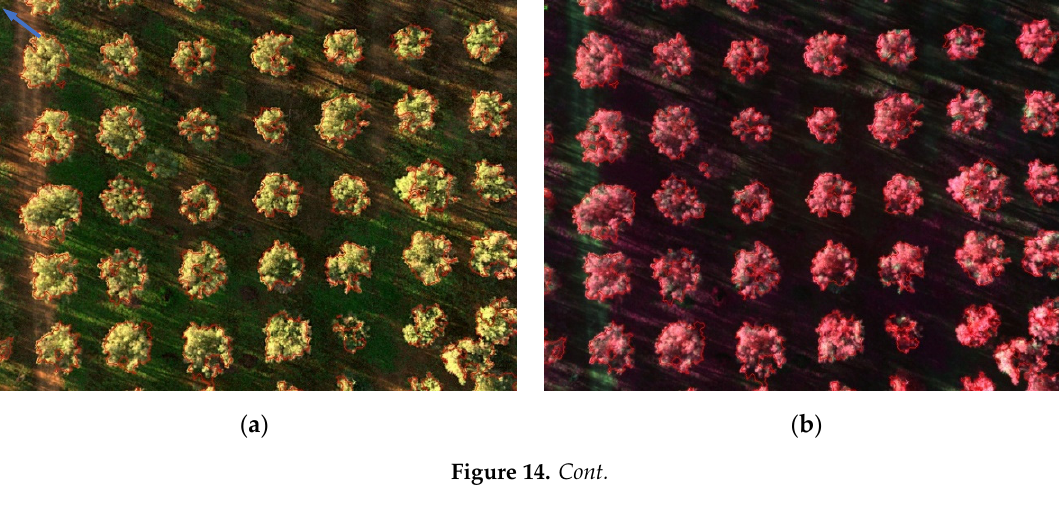
( d ) Figure 14. (a ) Segmented RGB image; ( b ) segmented CIR image; ( c ) NDVI image; ( d ) probability map. The blue arrow in the upper left corner of (a) indicates a classification error. 4. Discussion The results shown in the previous section indicate that high classifier sensitivity and precision were achieved in both training and test sets. It is worth noting that the test images were acquired in suboptimal conditions, with evident shadows cast on the ground and self-shadowing; however, both the segmentation and classification algorithms succeeded. This is very important, because due to logistic constraints, it is not always possible to survey a field under optimal irradiation, i.e., when the sun is directly overhead. Parameters such as gain and exposure time were optimized automatically by the multispectral camera according to shooting conditions and were saved in image metadata. According to manufacturer’s data, automatic gain control keeps the exposure below 2 ms. No attempt was made to correct specular reflection from vegetation, since it was considered negligible in the case of trees observed at that distance. Altitude and resolution were such that individual leaves were not discernible; however, that level of detail was not deemed necessary and the analysis was performed on the spectral content of the crown as a whole. Moreover, lowering the altitude would have increased the time necessary for the survey, reaching the autonomy limit of the drone, while air moved by propellers during close-up shots would have shaken branches. Leaves’ and branches’ fluttering due to wind was low (7–9 mph wind from NNW) during the survey; however, it should be noted that flutter, if significant, may reduce the accuracy and reliability of photogrammetry. Further details on the achieved result are discussed with the help of Figure 13 and Figure 14.